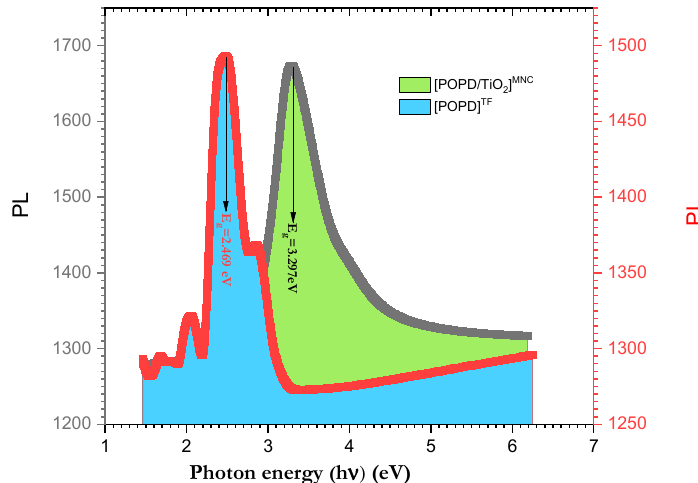
Figure 13. Photoluminescence spectra of [PoPDA] TF and [PoPDA/TiO 2 ] MNC. Commission Internationale de l’Eclairage (CIE) graphs (Figure 14) illustrate the emis- sion colors of [PoPDA] TF and [PoPDA/TiO 2 ] MNC , for [PoPDA] TF digital photographs obtained at h ν = 2.469 eV, which is located at the coordinates (0.32, 0.27), while the digital photographs for [PoPDA/TiO 2 ] MNC were obtained at h ν = 3.297 eV and located at the coordinates (0.33, 0.34). A significant change in the color of the emission can be figured out since the emission color changed from light purple for [PoPDA] TF to pale blue for [PoPDA/TiO 2 ] MNC . The effect of adding TiO 2 to PoPDA to fabricate [PoPDA/TiO 2 ] MNC results in making it close to emitting white light from a single material, giving it potential applications in lighting and display devices.